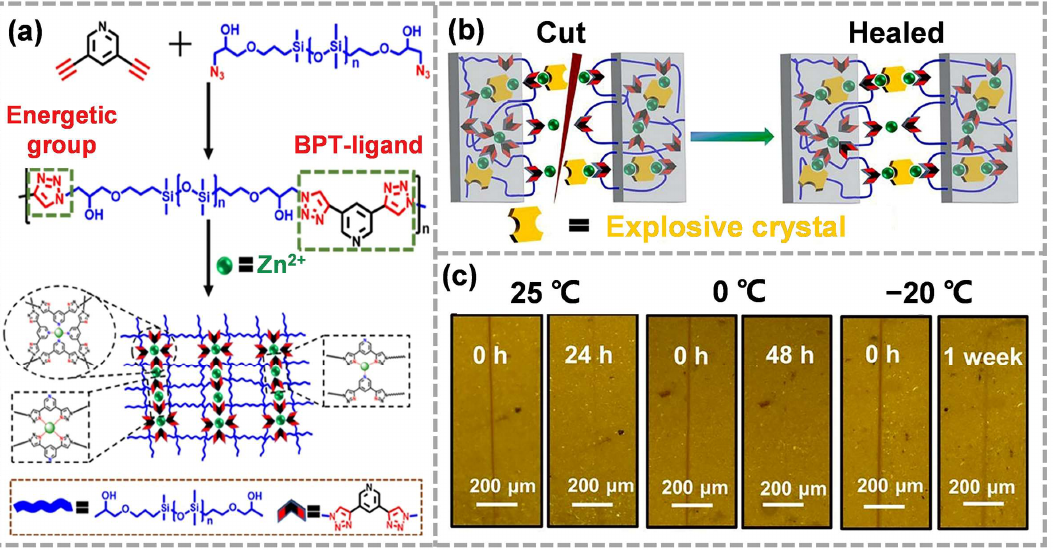
Figure 8. ( a ) Structural design and preparation of 3,5-BTP-PDMS-Zn polymer adhesive, ( b ) the self- healing mechanism for ECMs with 3,5-BTP-PDMS-Zn as binders, ( c ) optical microscope photographs of ECMs bonded with 3,5-BTP-PDMS-Zn demonstrating crack-healing (reproduced from Ref. [118] with permission; Copyright Elsevier, 2021).